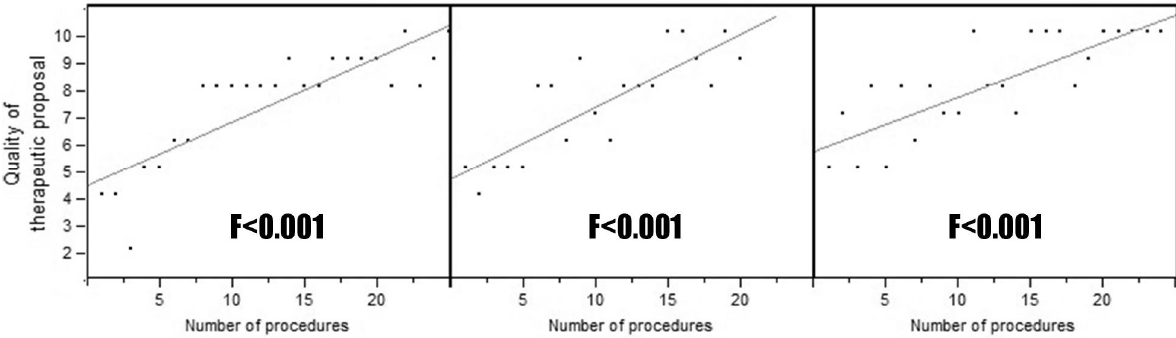
Figure 3. Linear regression of the appropriateness of the therapeutic proposal for each resident.